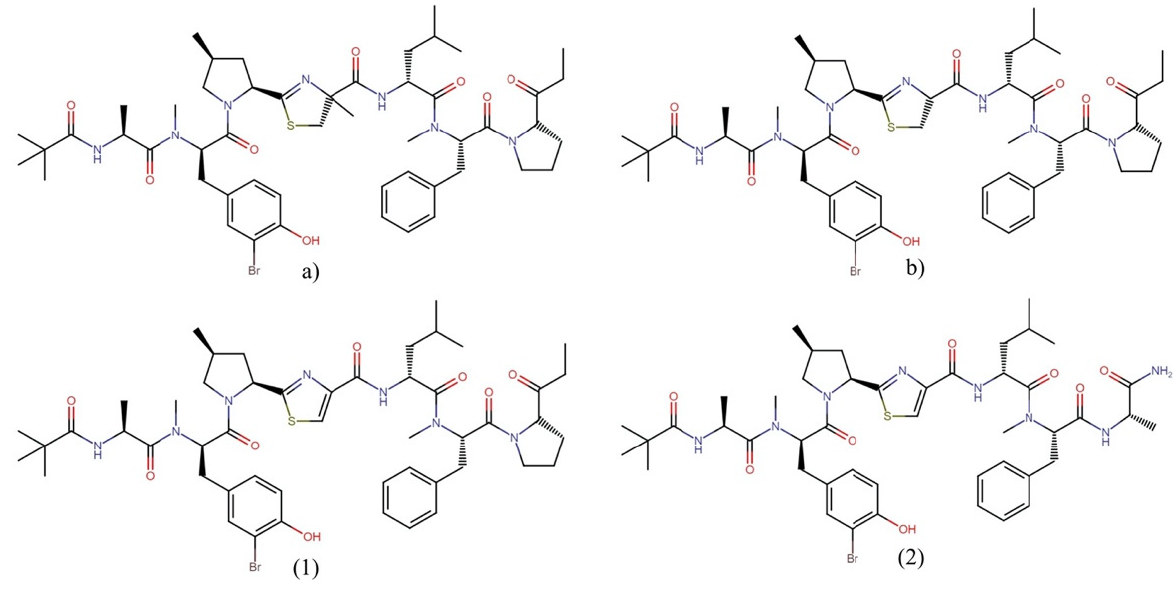
Figure 4. Chemical structures of ( a ) bisebromoamide, ( b ) norbisebromoamide, and their derivatives ( 1 ) and ( 2 ).